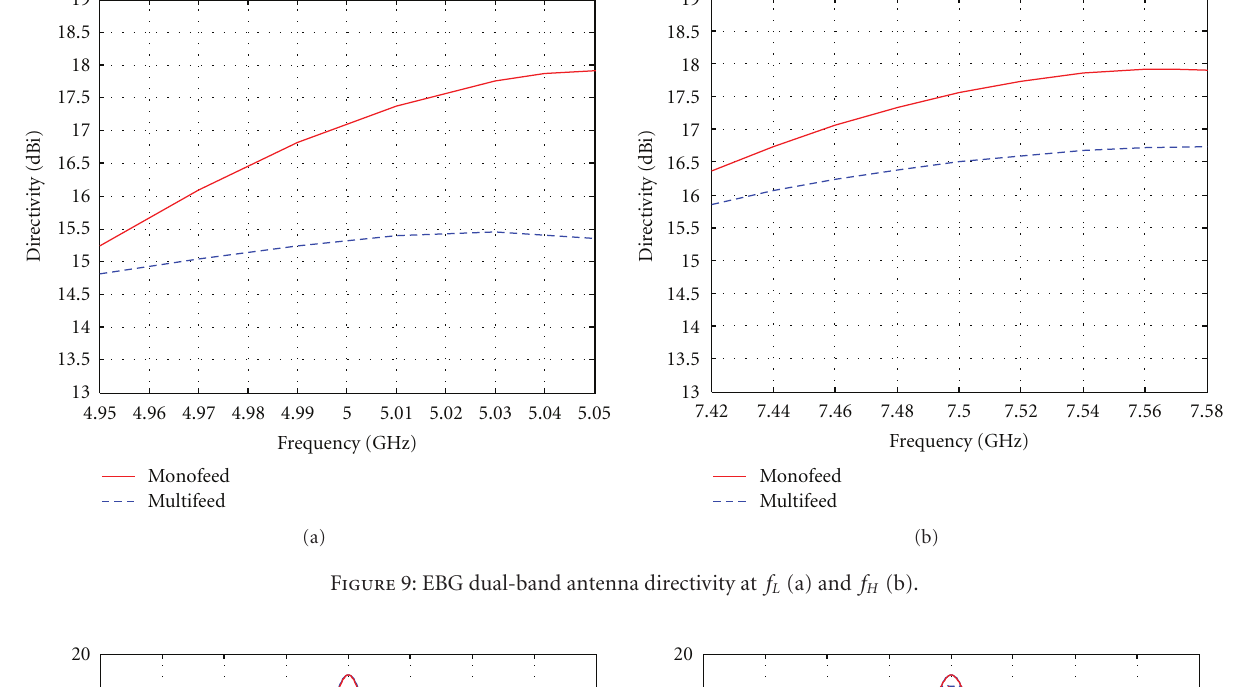
Figure 9: EBG dual-band antenna directivity at f L (a) and f H (b).